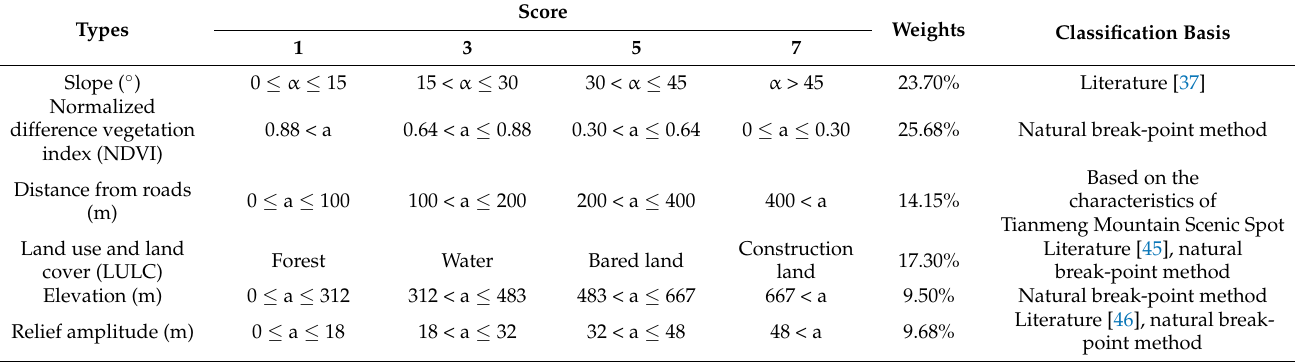
Table 6. The system of ecological-resistance